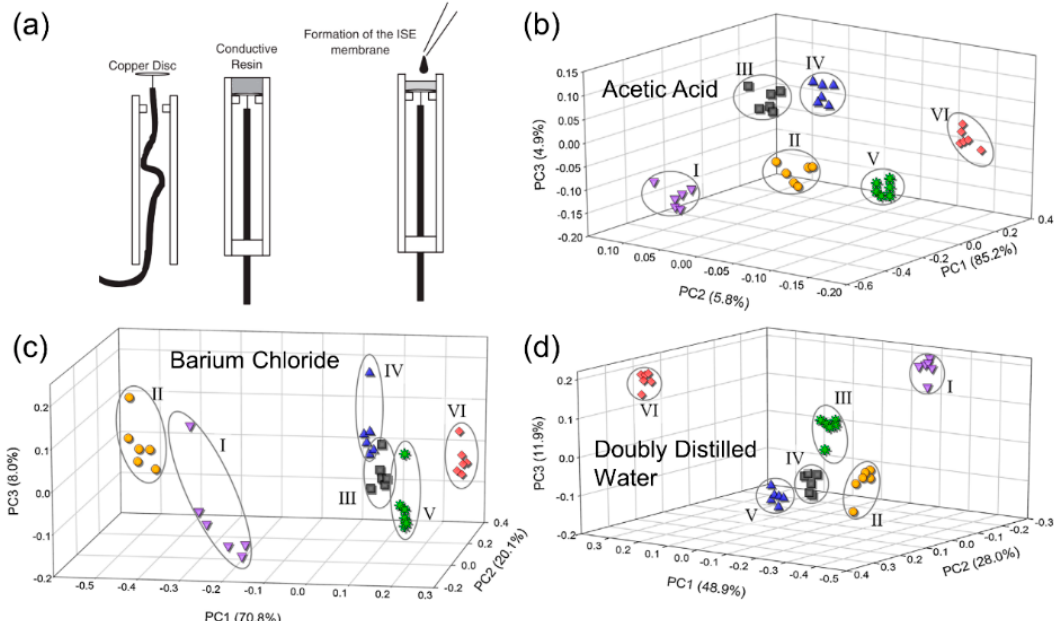
Figure 2. ( a ) Fabrication of ion-selective electrode with electrical solid contact based on epoxy–graphite composite [33] (reprinted with permission of the publisher (Taylor and Francis Ltd.), license 4684171258815); 3D scores plots of the extraction method used ( b ) acetic acid, ( c ) barium chloride, and ( d ) doubly distilled water [32] (reprinted with permission of the publisher (John Wiley and Sons), license 4684171056214).